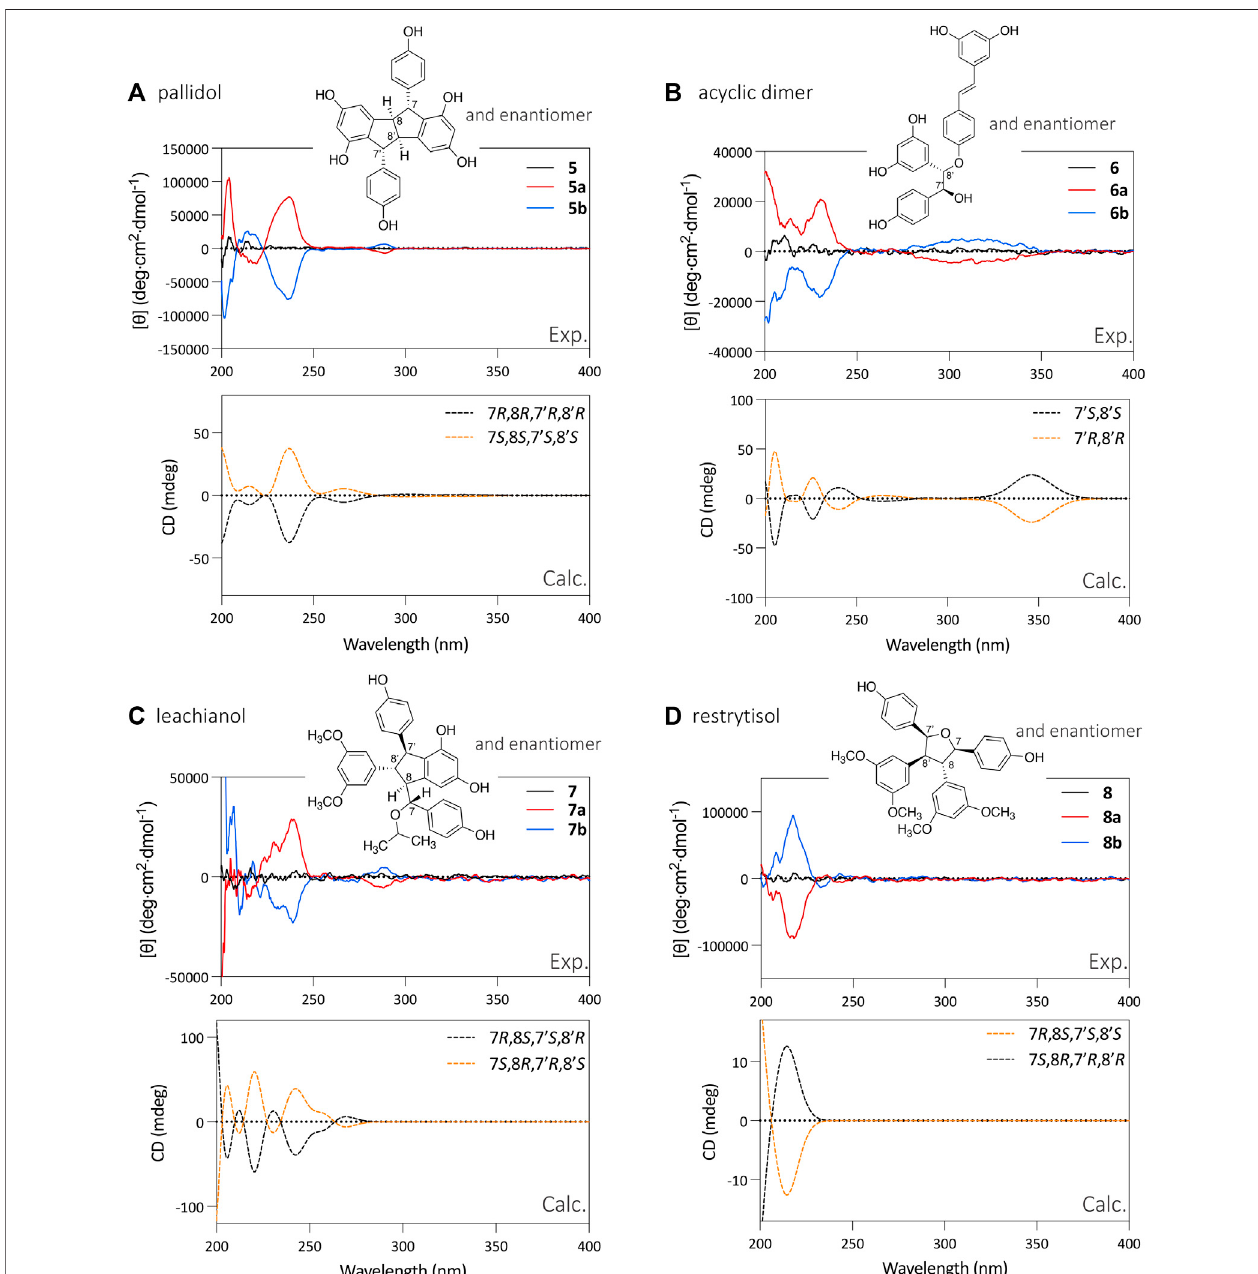
FIGURE 4 | Relative con fi guration, experimental ECD spectra and calculated ECD spectra of the enantiomeric pairs of compounds 5 – 8 . Experimental red curve matches with the calculated orange one, while the experimental blue curve matches with the experimental black curve. (A) pallidol-type 5 . (B) acyclic dimer-type 6 . (C) leachianol-type 7 . (D) restrytisol-type 8